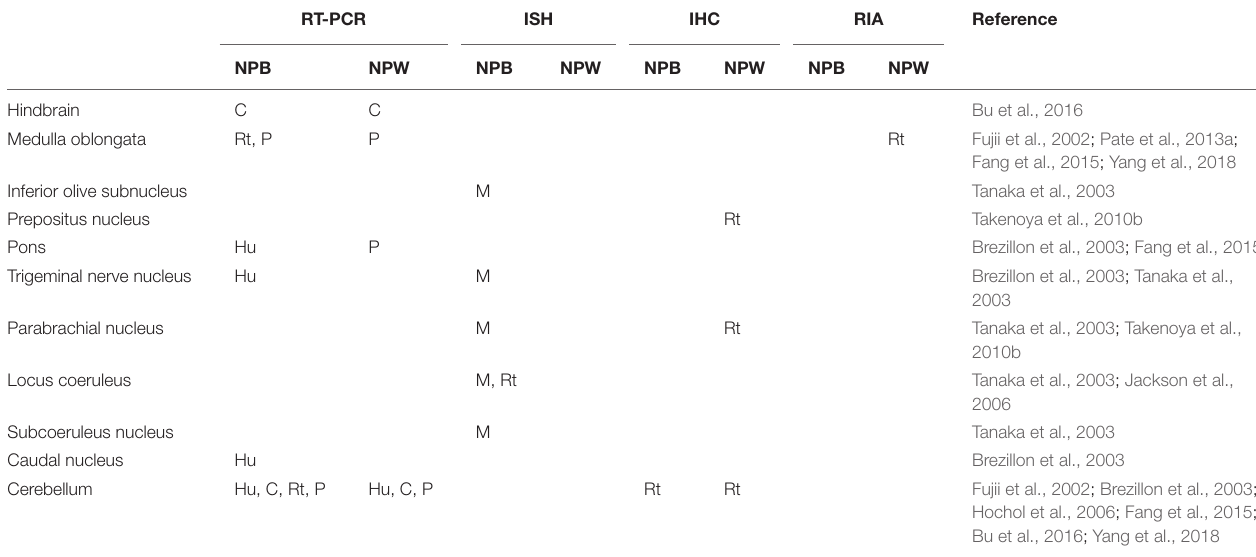
TABLE 4 | Localization of NPB and NPW in the